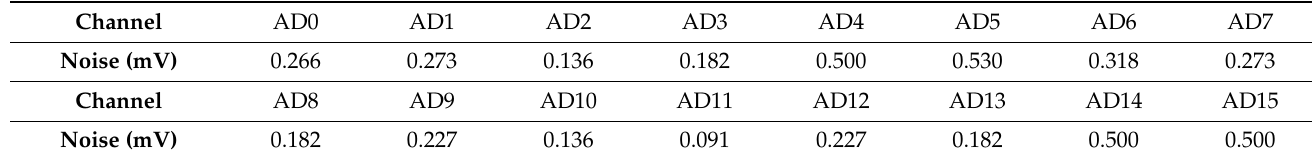
Table 1. Noise evaluation of each channel of the ADC.